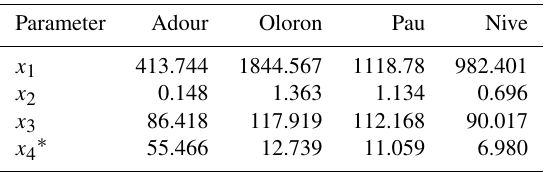
Table C1. Calibrated hydrological parameters of the four upstream hydrological catchments from the Adour multi-D hydrographic net- work